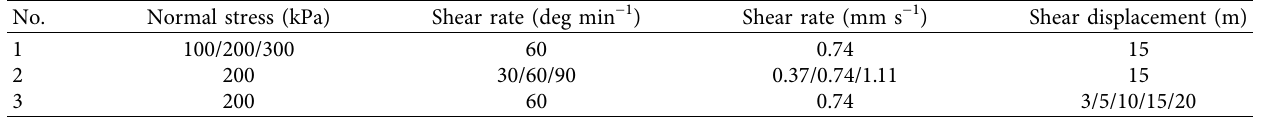
Table 2: Details of the tests